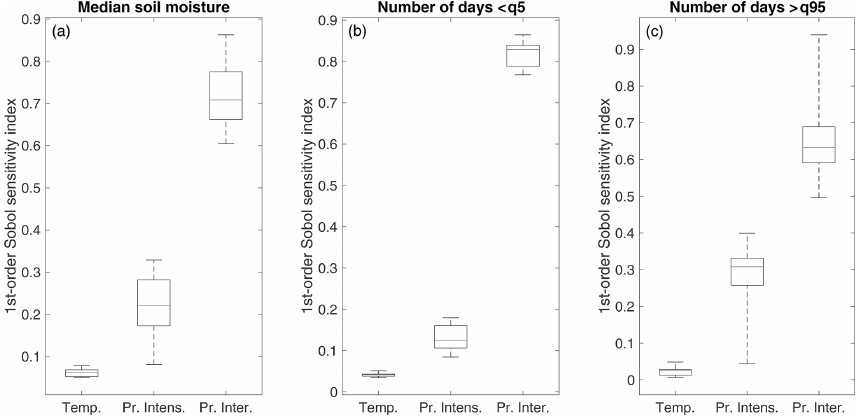
Figure 10. First-order Sobol sensitivity index of median soil moisture (a) , the number of days under drought conditions (b) , and the number of days with water excess (c) to temperature, precipitation intensity, and precipitation intermittence changes. Boxplots represent the distribution of the first-order Sobol indices for the 10